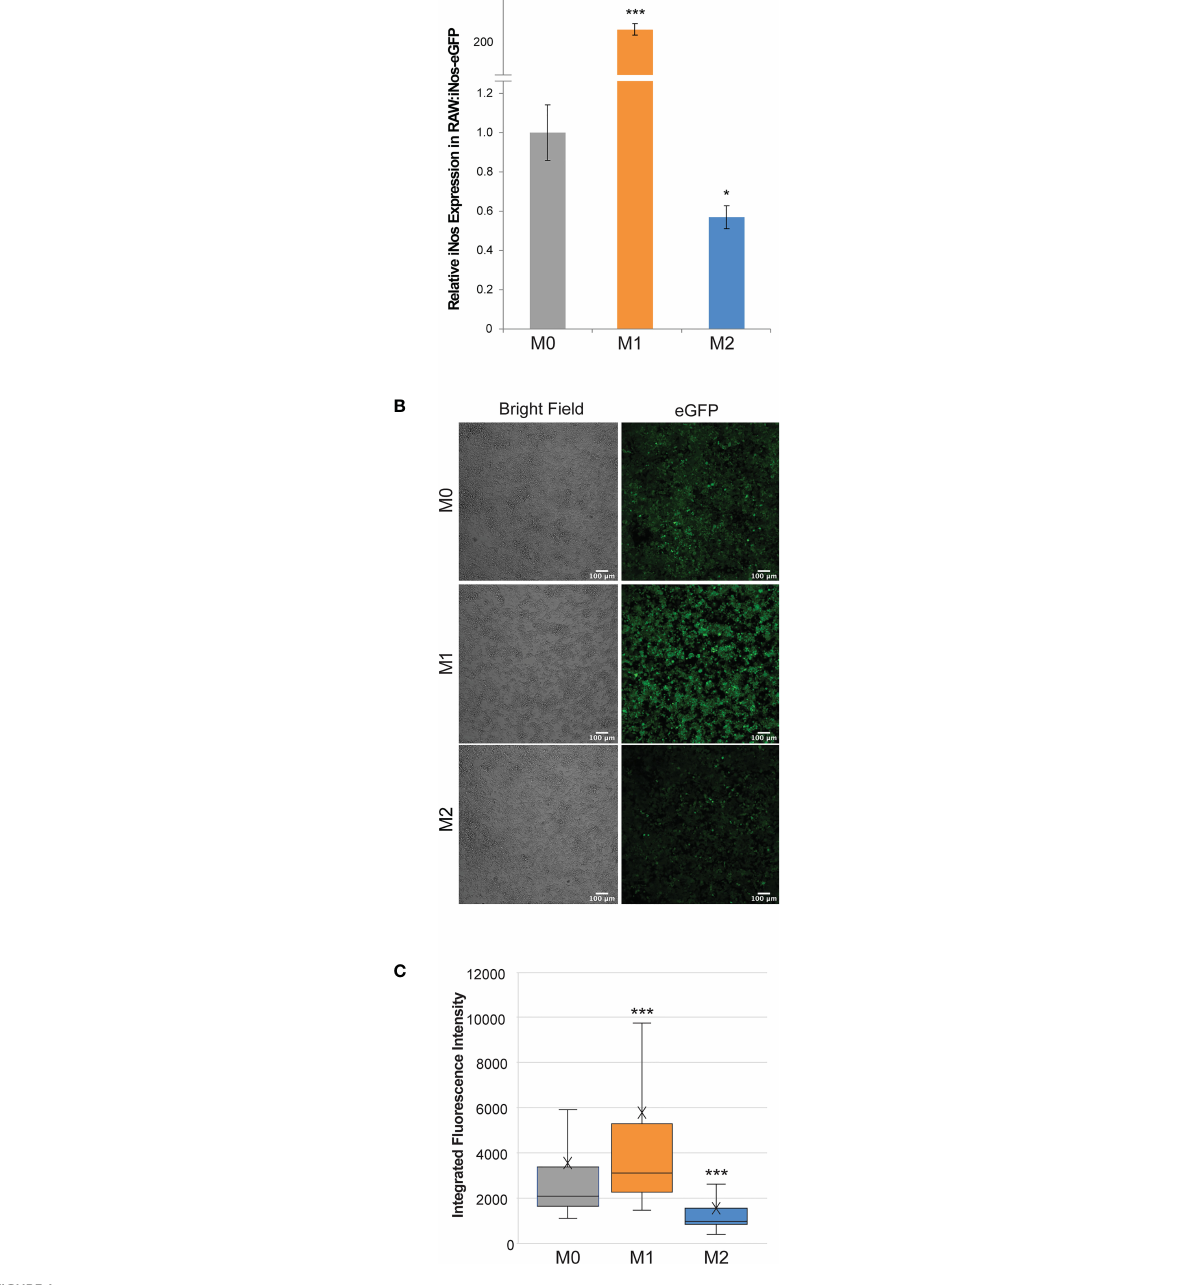
(Figure 3), reporter macrophages exposed to either 4T1 or EMT6 spheroids in the absence of PBI1 displayed decreased fl uorescence (Figure 5). Excitingly, a signi fi cant increase in iNos -eGFP signal was observed following treatment with PBI1, suggesting a shift of the